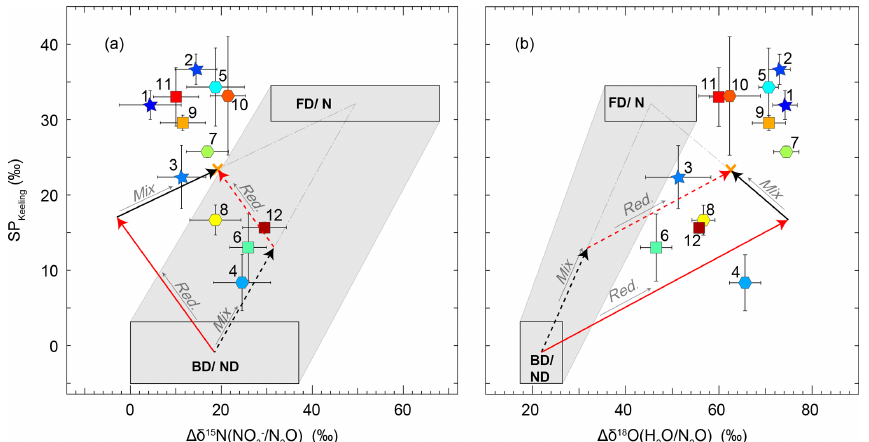
Figure 8. Source signatures of soil-emitted N 2 O for 22 to 24 June (stars 1–3), 9 to 12 July (squares 6, 9, 11, and 12), and 17 to 21 July (hexagons 4, 5, 7, 8, and 10). The colour coding of the symbols refers to WFPS, where blue corresponds to high and red corresponds to low WFPS (exact values in Table 3). The source signatures of fungal denitrification- and/or nitrification-derived N 2 O (FD/N) and bacterial- denitrification- and/or nitrifier-denitrification-derived N 2 O (BD/ND) are highlighted with rectangles according to the values given in Table 4, and the shaded area represents the mixing region of the two domains. The orange cross indicates the flux-averaged values of the respective source signatures. Red arrows denote the path of partial N 2 O reduction to N 2 , while black arrows indicate the direction of mixing with FD/N-derived N 2 O. Solid arrows indicate scenario 1 (first reduction, then mixing), while dashed arrows indicate scenario 2 (first mixing, then reduction). (a) SP versus (cid:49)δ 15 N map according to Koba et al. (2009), where (cid:49)δ 15 N = δ 15 N-NO − of soil-emitted N 2 O according to Lewicka-Szczebak et al. (2017), where (cid:49)δ 18 O = δ 18 O-N 2 O − δ 18 O-H 2 O, the isotope effect between soil water, and formed N 2 O. (cid:49)δ 18 O for BD/ND is considered to be constant because of the high oxygen exchange between soil water and reaction intermediates at high WFPS. An exemplary illustration is provided in the Supplement (Fig.